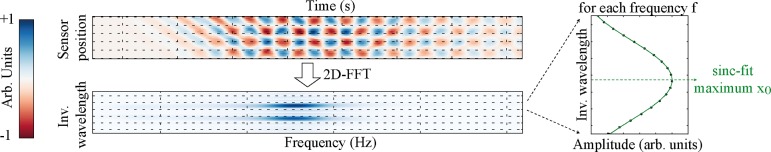
Illustration of the analysis procedure.